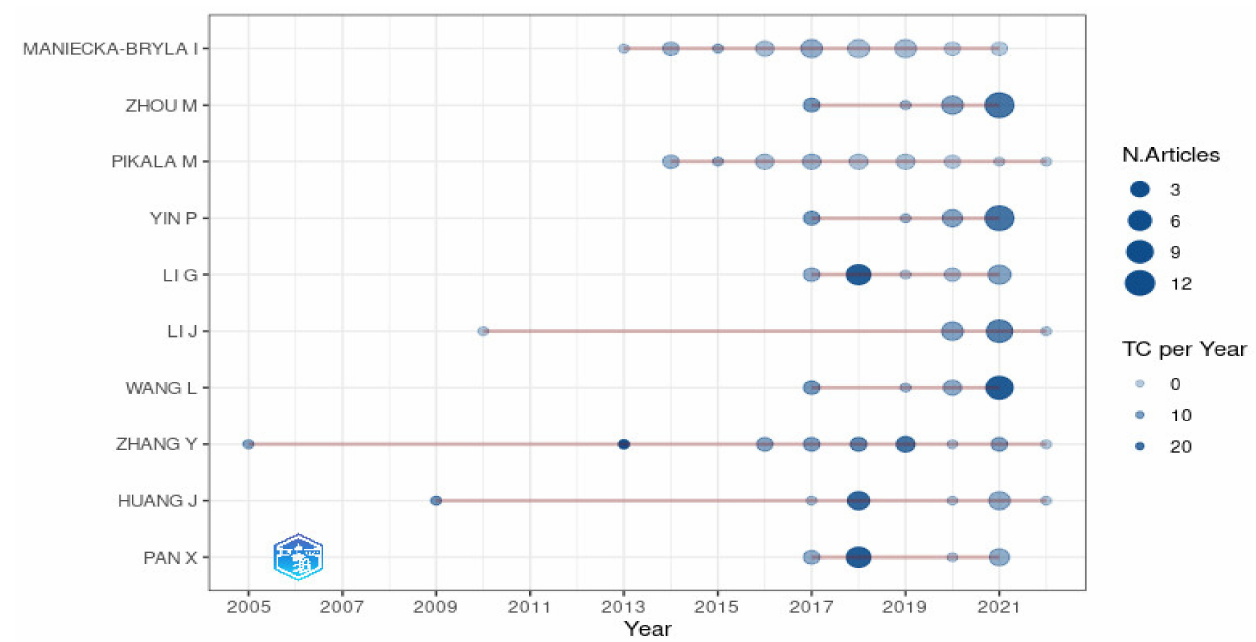
Figure 4. The top authors’ production over time. Note: The size of the circles represents the frequency of articles published in a year; the intensity of the circles’ color represents the papers’ relevancy.